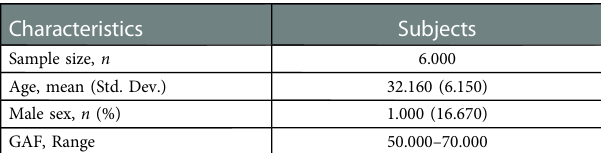
Table 2 Demographics of subjects measured